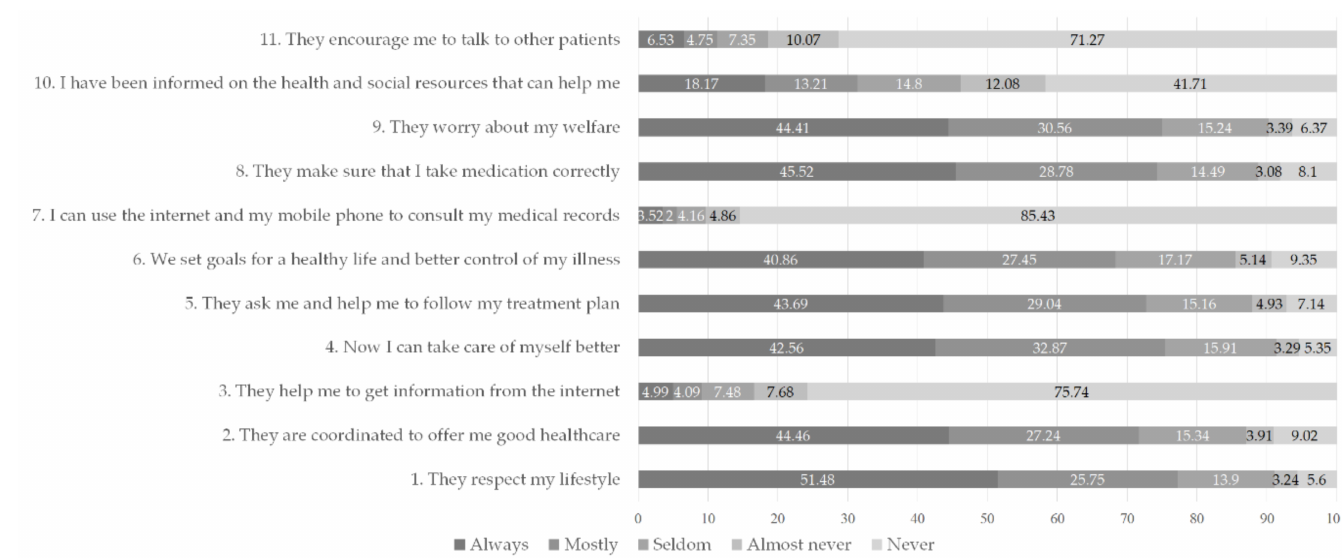
Figure 1. Distribution of patients’ responses to IEXPAC items. Numbers in bars represent the percentage of respondents who responded to each option. Missing answers ( n = 1, 0.03%) were removed to make the